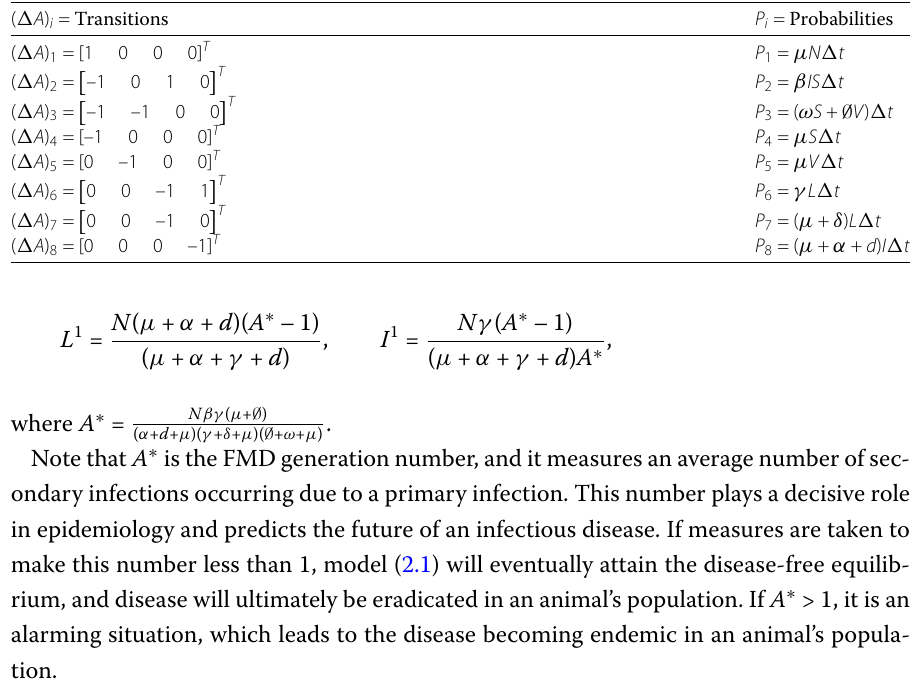
Table 1 Transition of the FMD